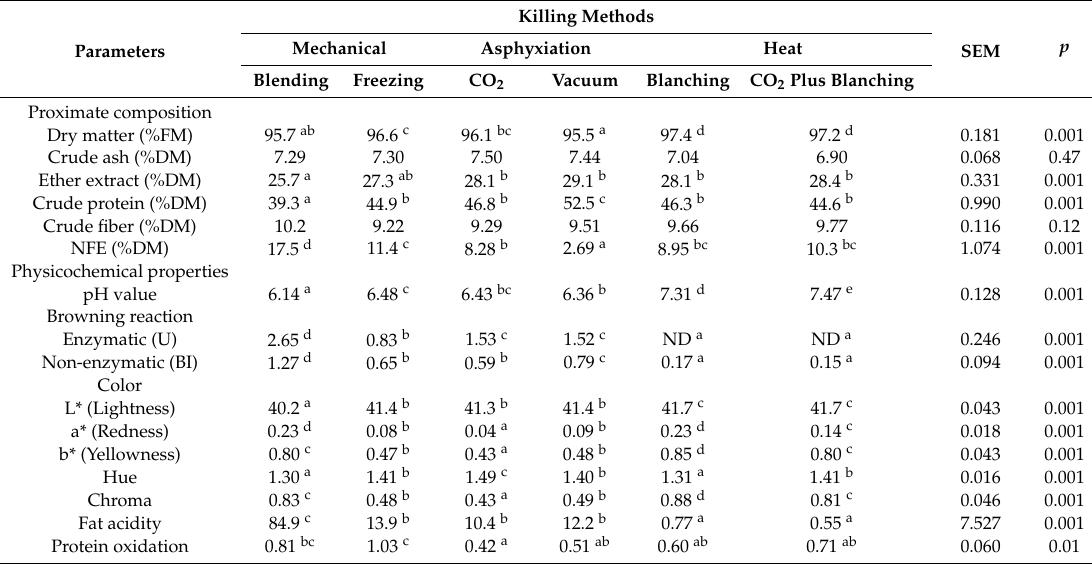
Table 2. Proximate compositions and physicochemical properties of BSF larvae after killing with di ff erent processing.